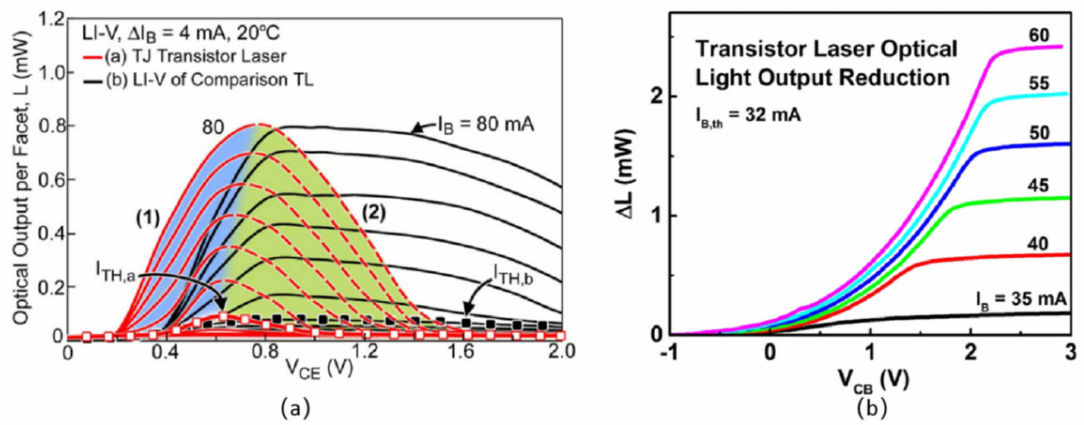
Figure 11. ( a ) Dependence of light output on V CE . Compared with ordinary TL, the output light intensity of TJ–TL is more dependent on voltage [61]. ( b ) The sensitivity of the output light intensity change ∆ L to V CE with various I B values [64]. Reproduced from Refs. [61,64], with the permission of AIP